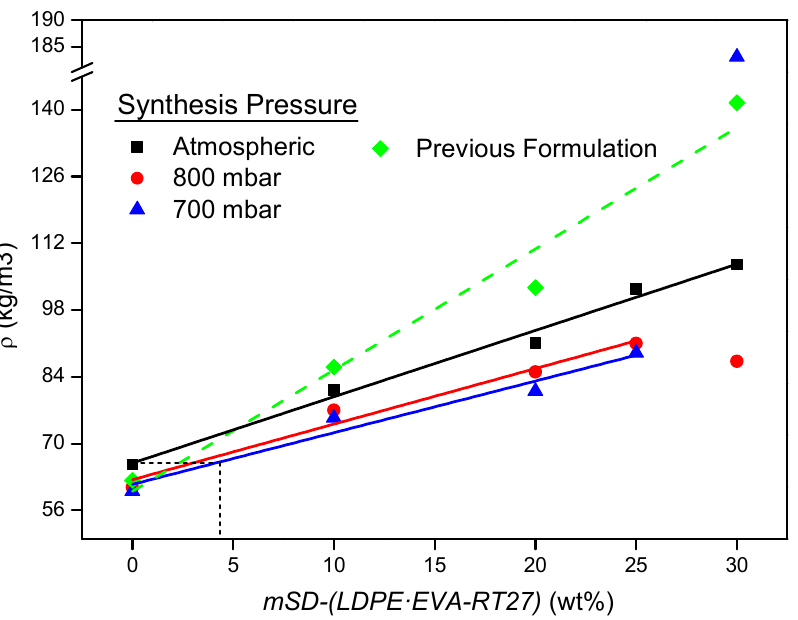
Figure 4. Apparent densities of the composites.